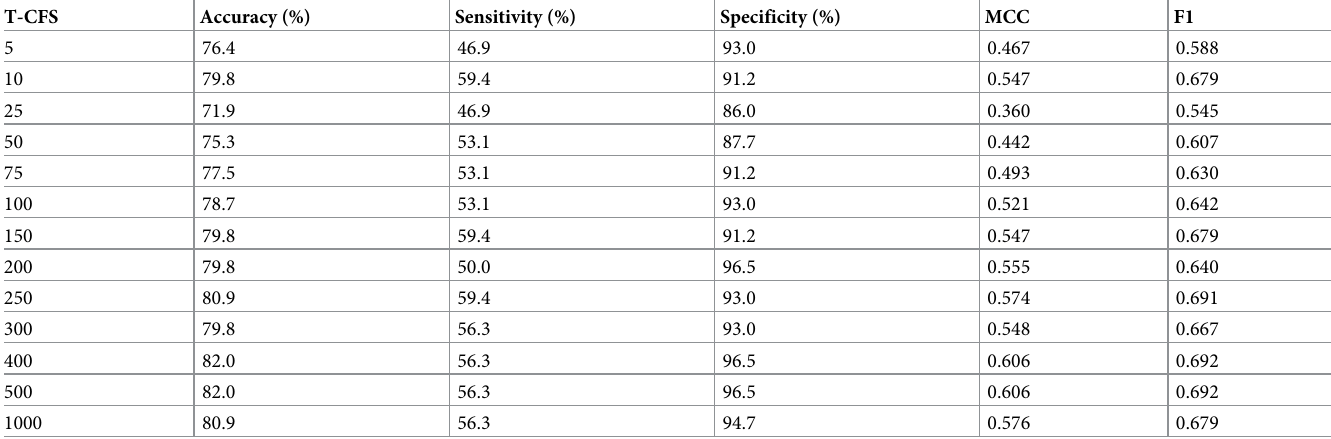
Table 4. Tree optimization for best model (T-CFS).